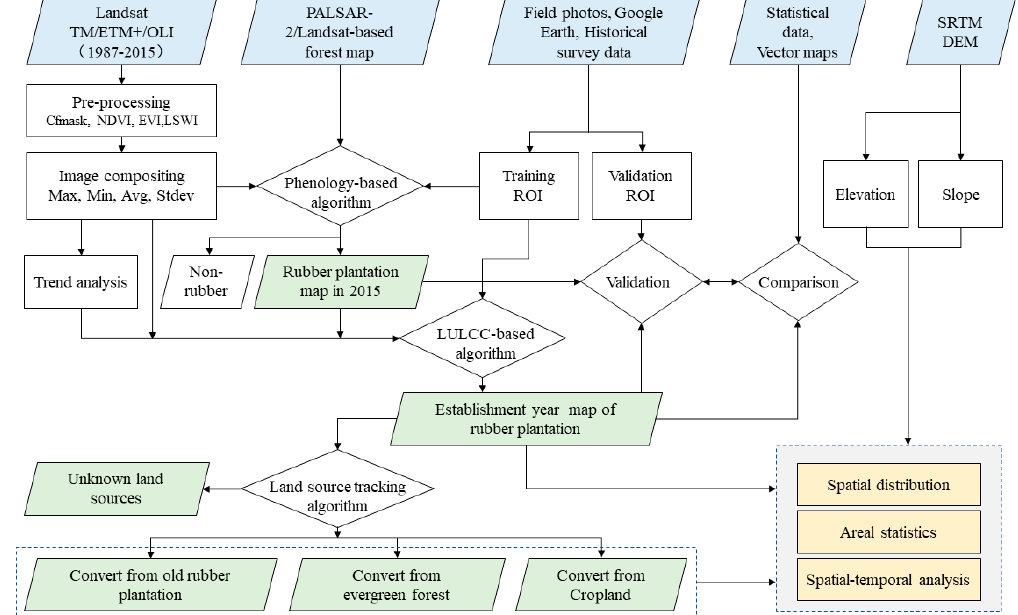
Figure 3 . Workflow of mapping the establishment year of rubber plantations and pre-conversion land cover types.